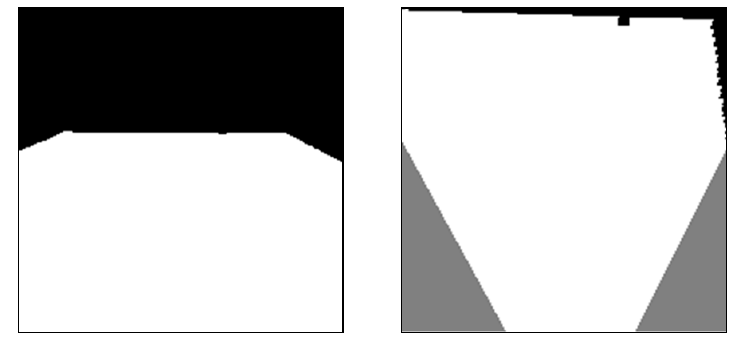
Figure 8. Source image and constructed frontal plane. Based on the information perception of the monocular camera bird’s view in Figure 9, mobile robot path planning will be designed entirely.